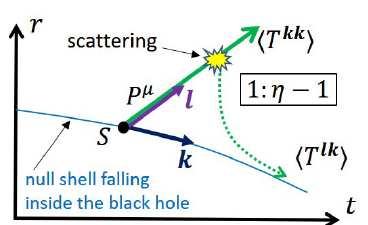
Figure 10. The meaning of a phenomenological function η